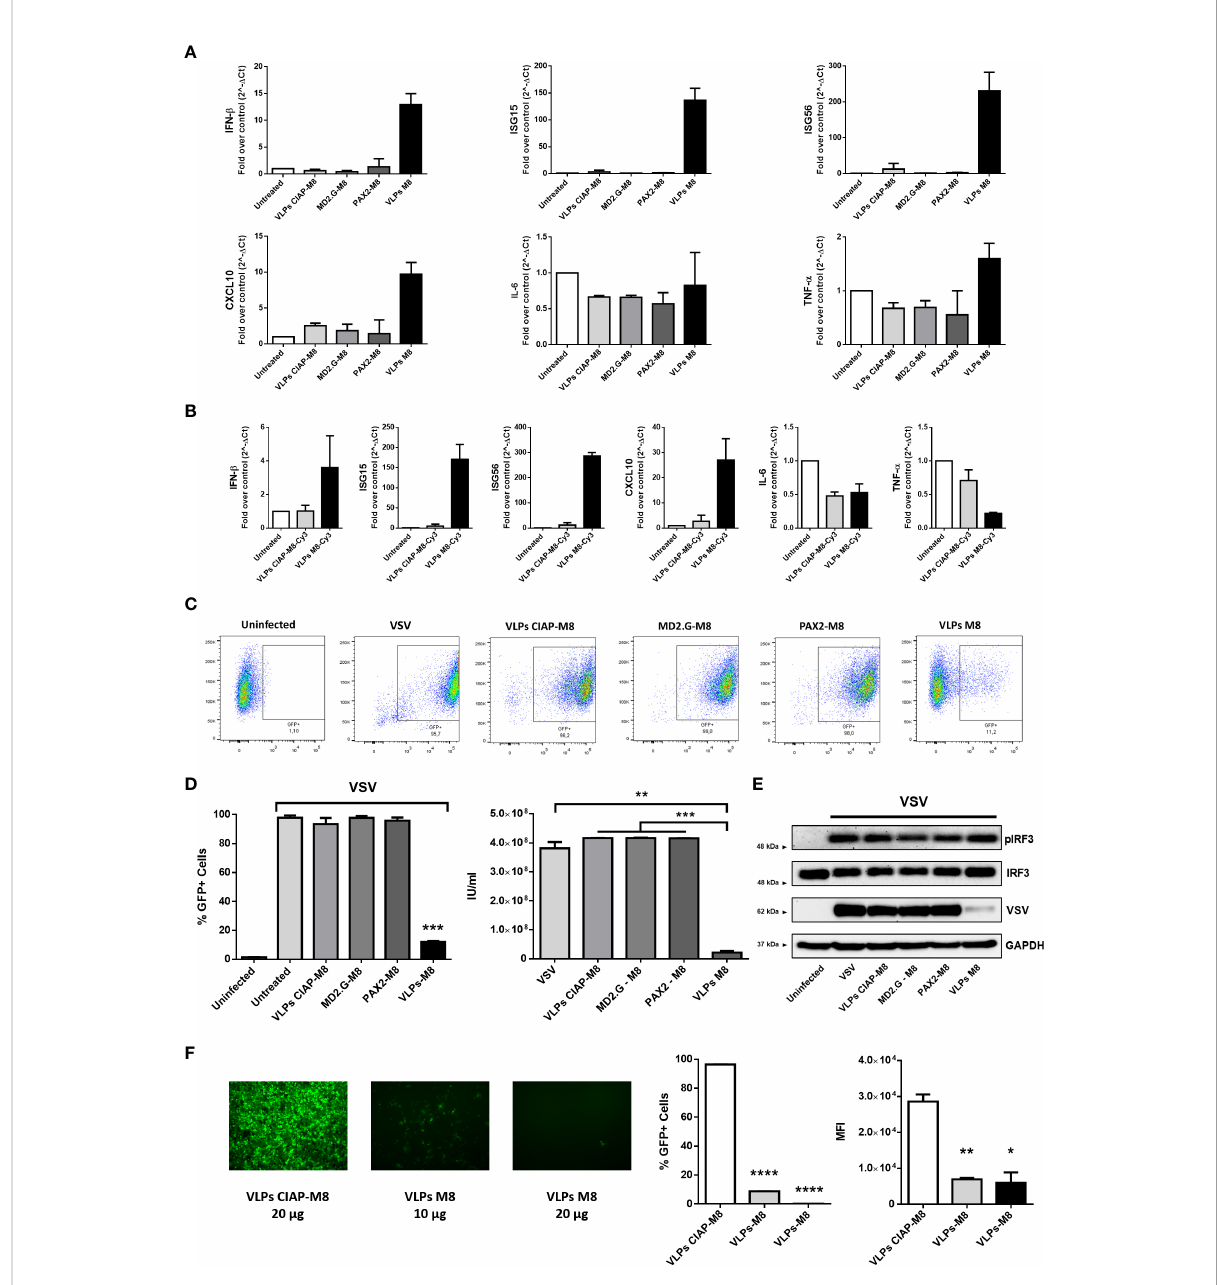
FIGURE 2 Antiviral potential of VLPs-M8 (A) Gene expression levels of IFN- b , ISG15, ISG56, CXCL10, IL-6 and TNF- a in A549 were quanti fi ed by qPCR after 48h of indicated treatments (20µg). Results are normalized to the b -Actin gene and expressed as fold of increase relative to control (Untreated), set as 1. (B) Gene expression levels of IFN- b , ISG15, ISG56, CXCL10, IL-6 and TNF- a in A549 were quanti fi ed by qPCR after 48h of treatment with 2.5*10 3 IU of VLPs-M8-Cy3 or VLPs-CIAP-M8-Cy3, or left untreated. Results are normalized to the b -Actin gene and expressed as fold of increase relative to control (Untreated), set as 1. (C) Flow cytometry analysis representative of GFP expression in cells treated as indicated for 48h and then infected for 24h with VSV-GFP. (D) Analysis of VSV infection and replication in cells treated with VLPs. Left, histogram indicating the percentage of GFP positive A549 cells; right, viral titer calculated on VERO E6 cells treated with supernatant of A549 cells (left panel). (E) Immunoblot analysis representative of IRF3 activation and VSV-GFP protein expression in A549 whole cell extract. Cells were treated as indicated for 48h and infected with VSV-GFP (MOI 0.1) for 24h; protein expression was normalized on GAPDH. (F) Therapeutic potential of VLPs-M8. Left panels, images representative of A549 cells infected with VSV-GFP (MOI 0.001) and treated 1h post-infection with VLPs-CIAP-M8 or VLPs-M8 at the indicated concentrations, images were obtained using a Olympus fl uorescence microscope (10x magni fi cation) and analyzed by ImageJ. Central and right panels, fl ow cytometry analysis of GFP expression at 24hpi in A549 cells treated with VLPs post-infection; central panel indicates the percentage of GFP positive cells, right panel indicates the Mean Fluorescence Intensity. Data represent mean±SEM from 3 independent experiments. Statistical signi fi cance was de fi ned as follows: *p < 0.05, **p<0.01, ***p<0.001, and